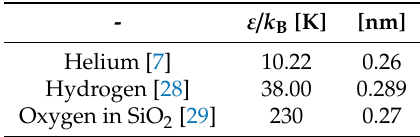
Table 1. Lennard-Jones potential